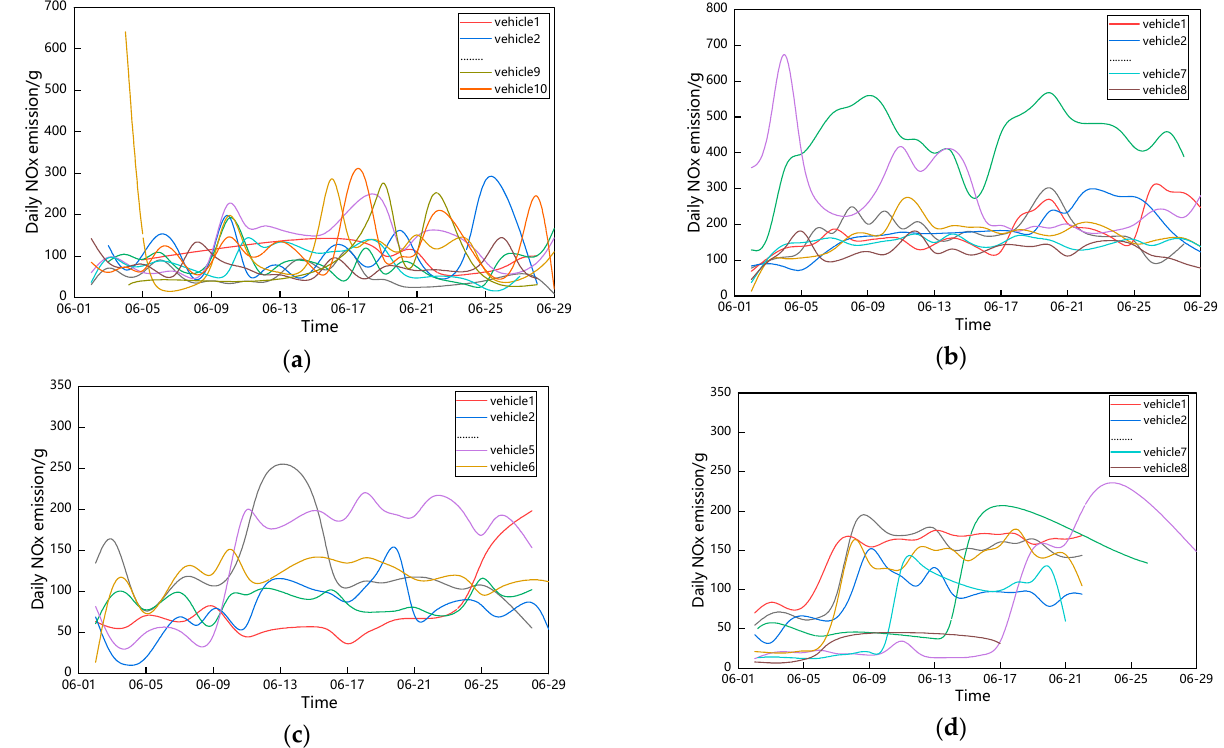
Figure 7. Refueling vehicles NOx emission at unregistered gas stations in June. ( a ) Unregistered gas station No. 6; ( b ) Unregistered gas station No. 7; ( c ) Unregistered gas station No. 8; ( d ) Unregistered gas station No. 9.